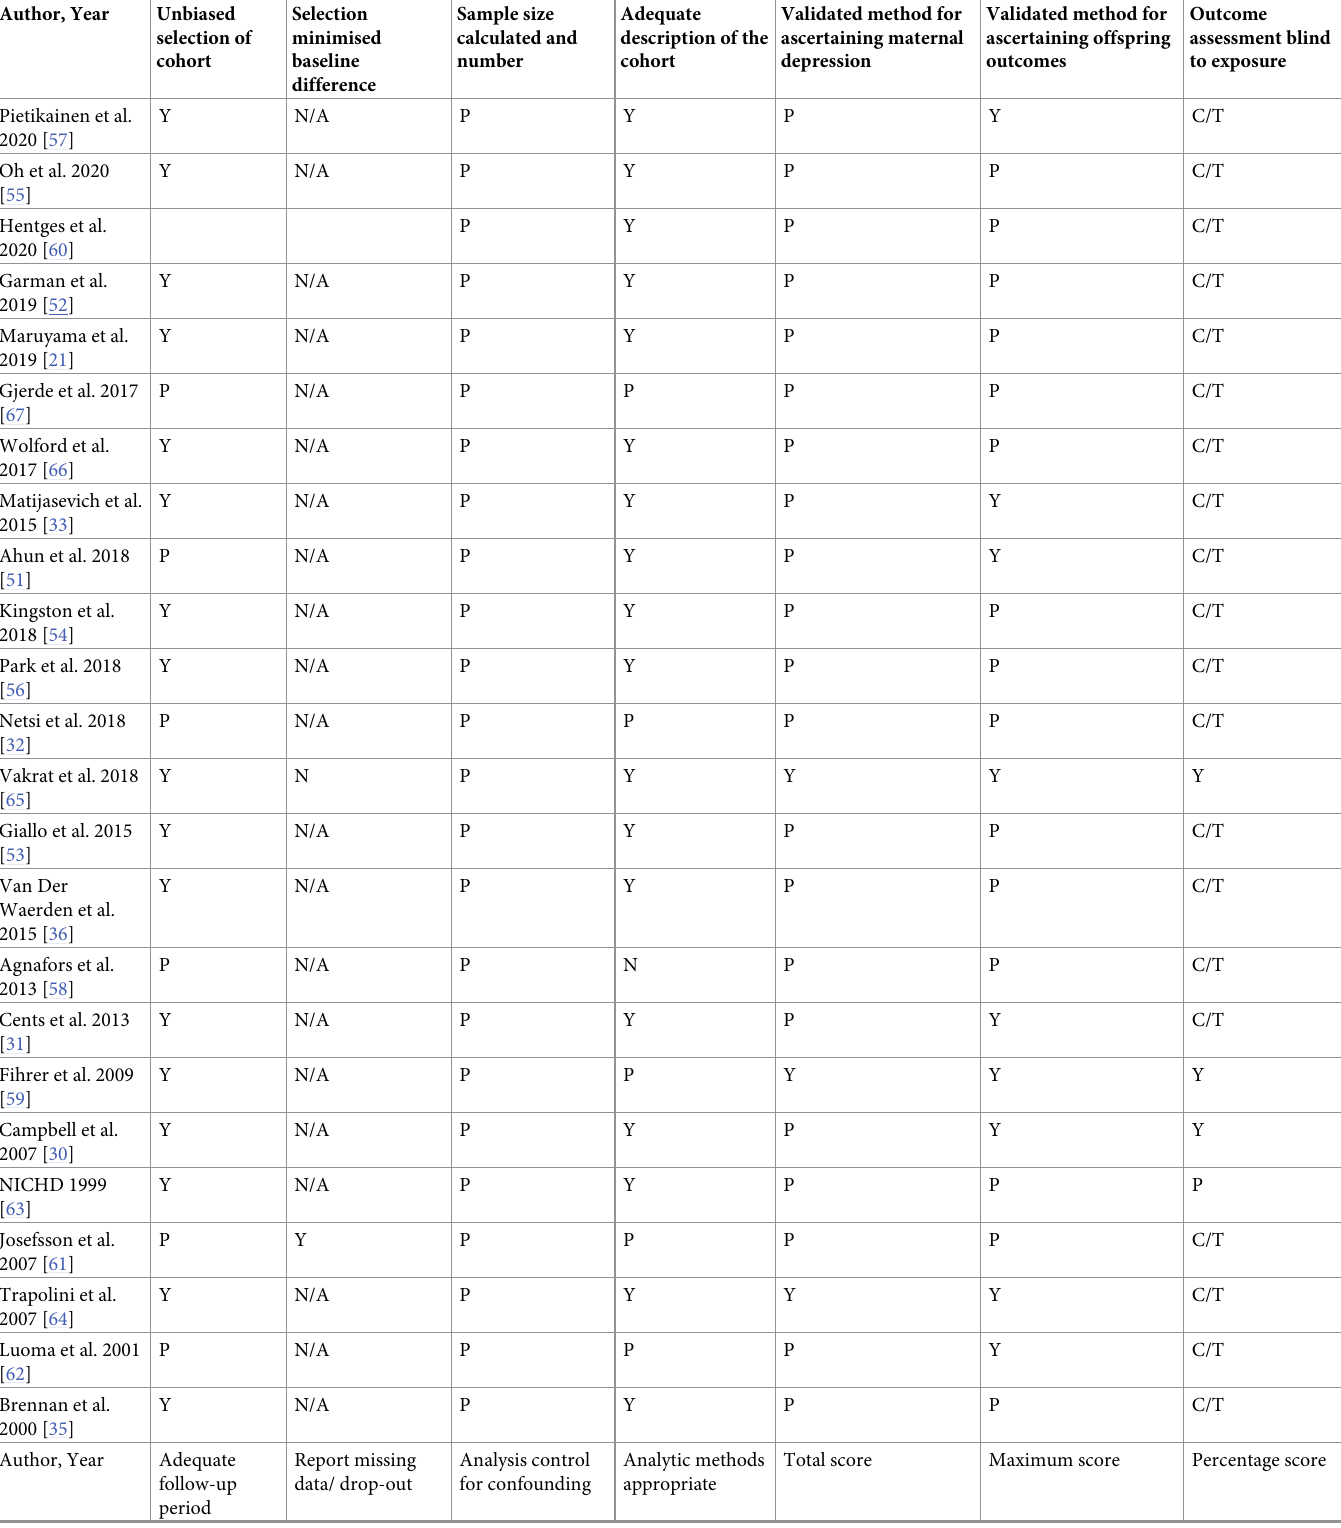
Table 3. Quality